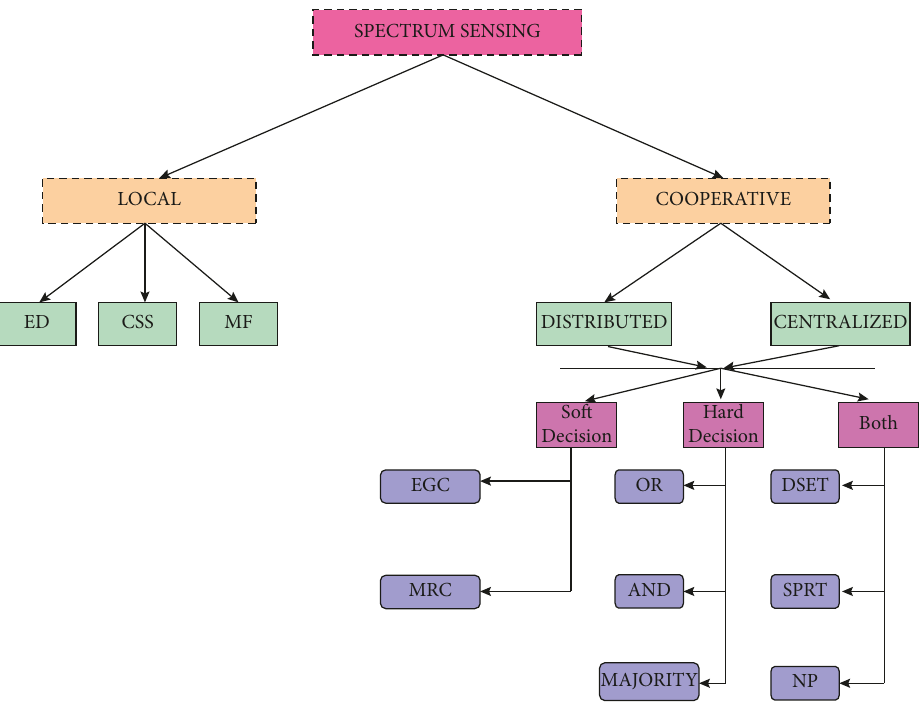
Figure 13: A taxonomy of spectrum sensing strategies.